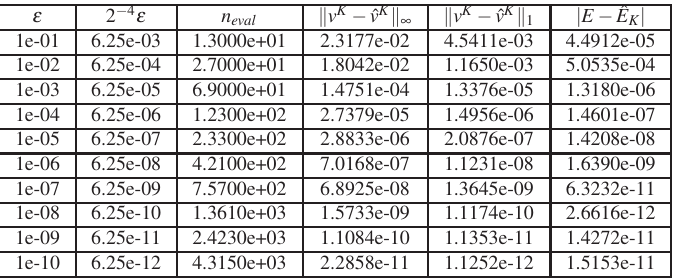
Table 10 Parameters as specified in Table 1 for f 1 , K = 15 and the PCHIP rule. ε k = ε varies between 10 − 1 and 10 − 10